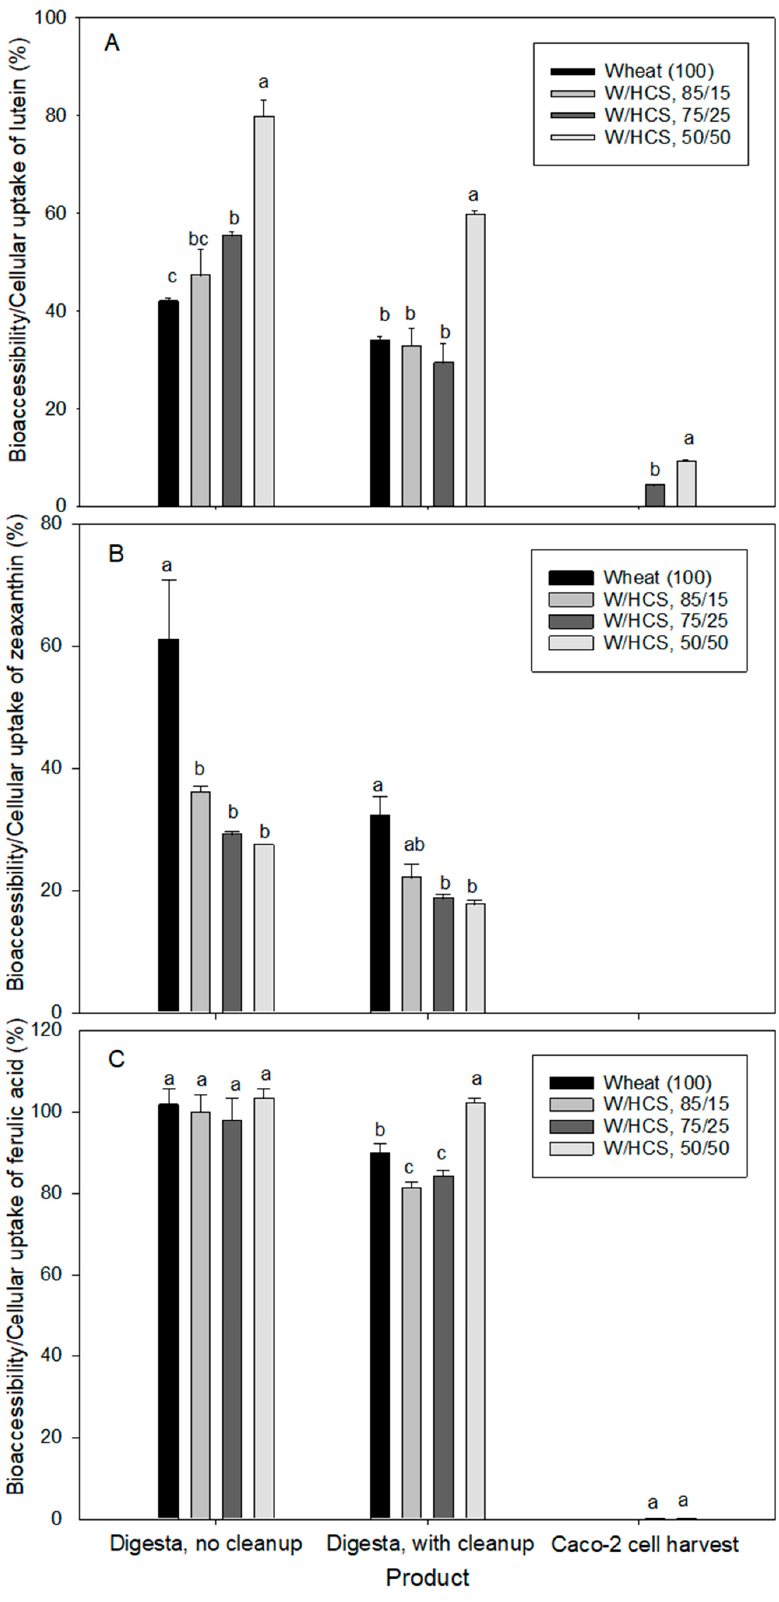
Figure 2. In vitro bioaccessibility of lutein from bread intestinal digests without cleanup ( A ) and with cleanup ( B ) and its Caco-2 cellular uptake ( C ). Bars with the same letter are not significantly different at p <